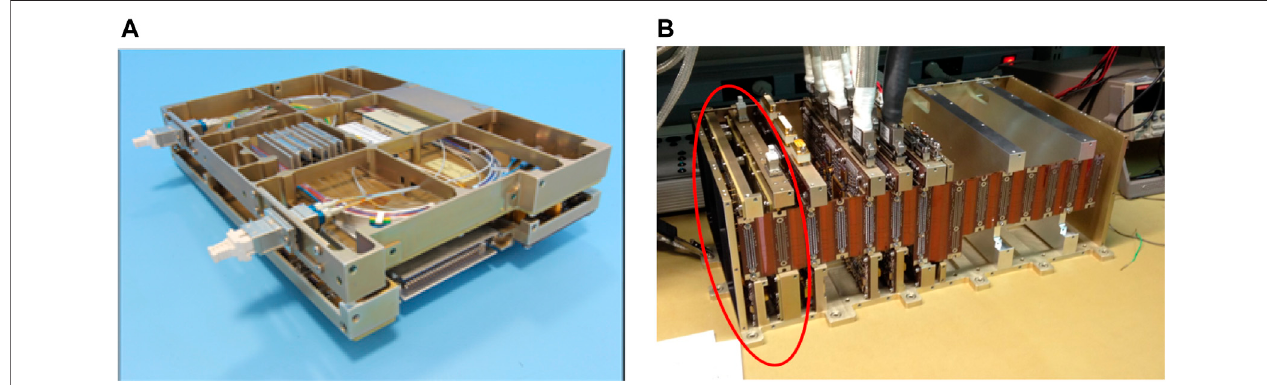
FIGURE 13 | (A) FOS Module and (B) pre-integration on Airbus DS RTU2015.